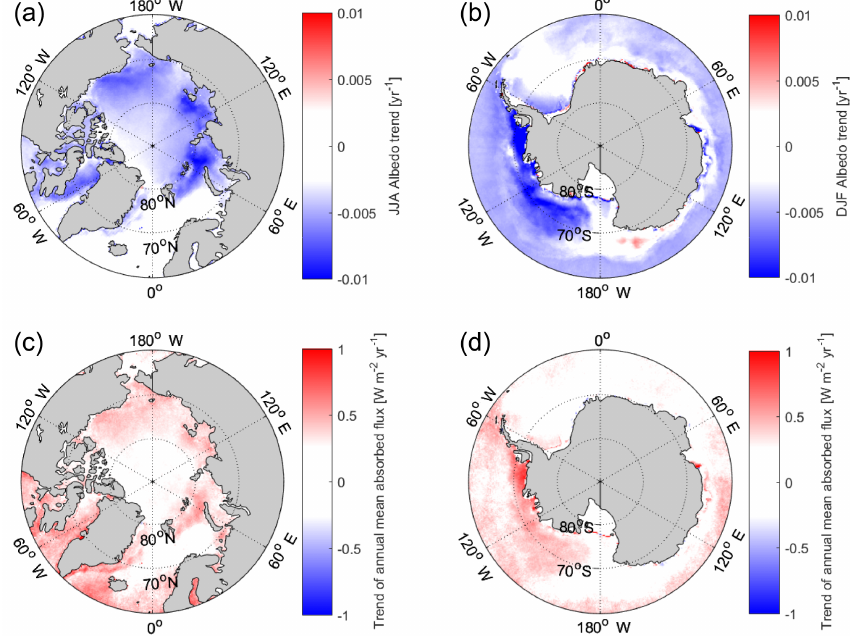
Figure 2. Spatial distribution of trends in surface albedo and overall energy deposition into the polar oceans: trends (yr − 1 ) of mean daytime summer sea ice albedo in the Arctic (a) and Antarctic (b) and trends (Wm − 2 yr) of shortwave energy flux (c, d) absorbed by the ice–ocean system. The latter inherently includes both changes in albedo and cloud cover due to the nature of the APP-x dataset.